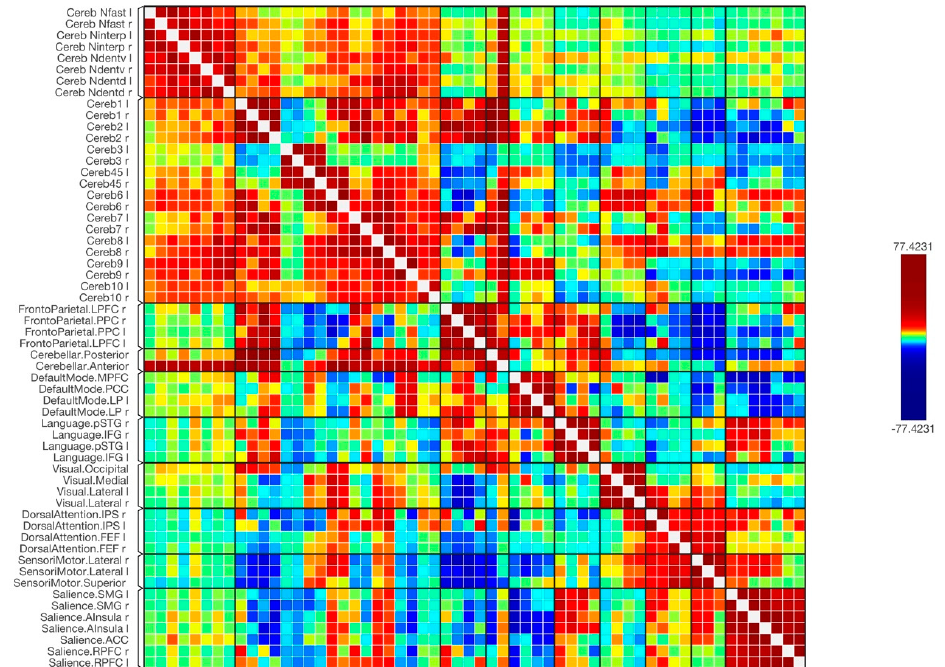
Figure 5. The matrix of the functional connectivity of the cerebellar lobules and their nuclei as well as the targeted brain networks is shown along with the statistical indications of the strength of the connection. In this figure, the connectivity was set with a statistical equalizer threshold (same threshold with a fixed color bar) to easily distinguish strong, weak, and negative connections.